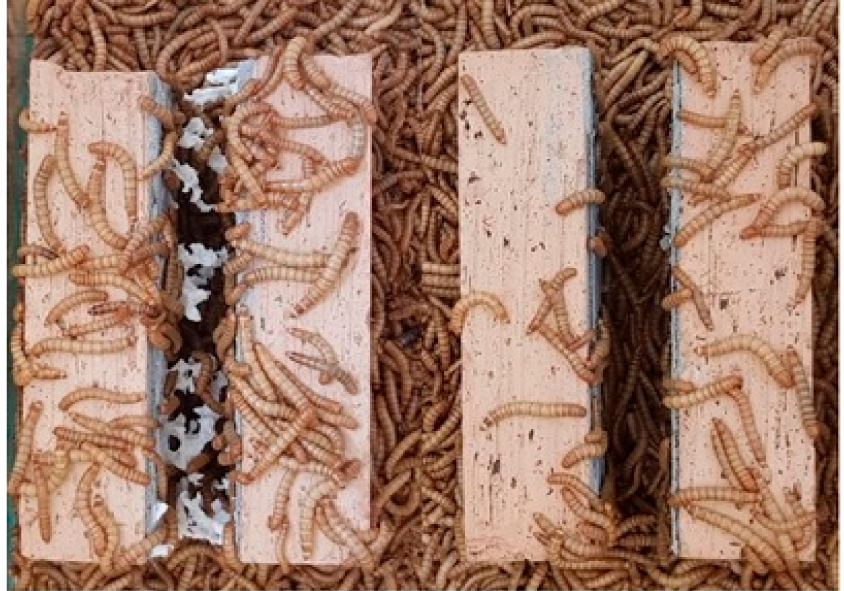
Figure 5. Specimens at the end of the experiment (left—with white EPS, right—with grey EPS).